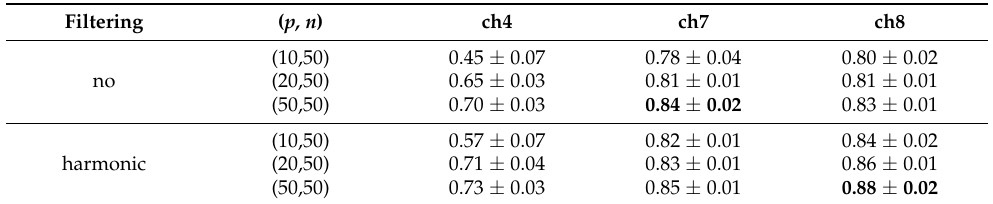
Table 11. A3S-Rec dataset: AUPRC of the baseline model with fine-tuning in several ( p , n ) combina- tions for ESD across all the recordings of channels 4-7-8.